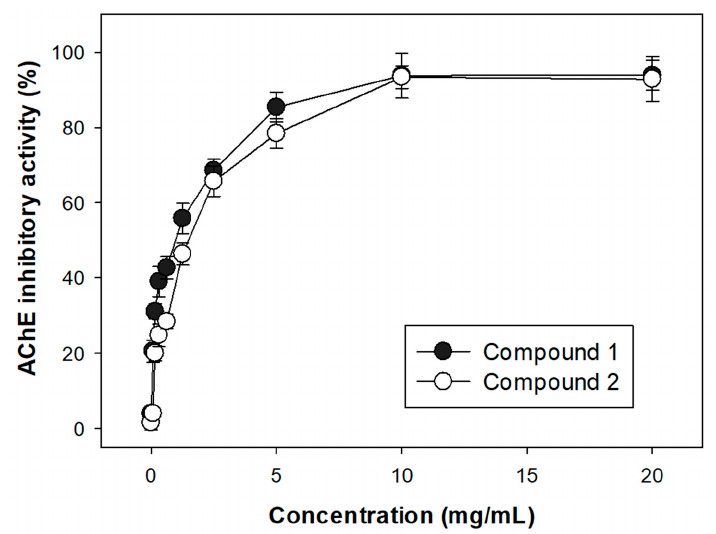
Figure 6. Acetylcholinesterase (AChE) inhibitory activity of purified thymine (compound 1 ) and hexahydropyrrolo [1,2-a] pyrazine-1,4-dione (compound 2 ).